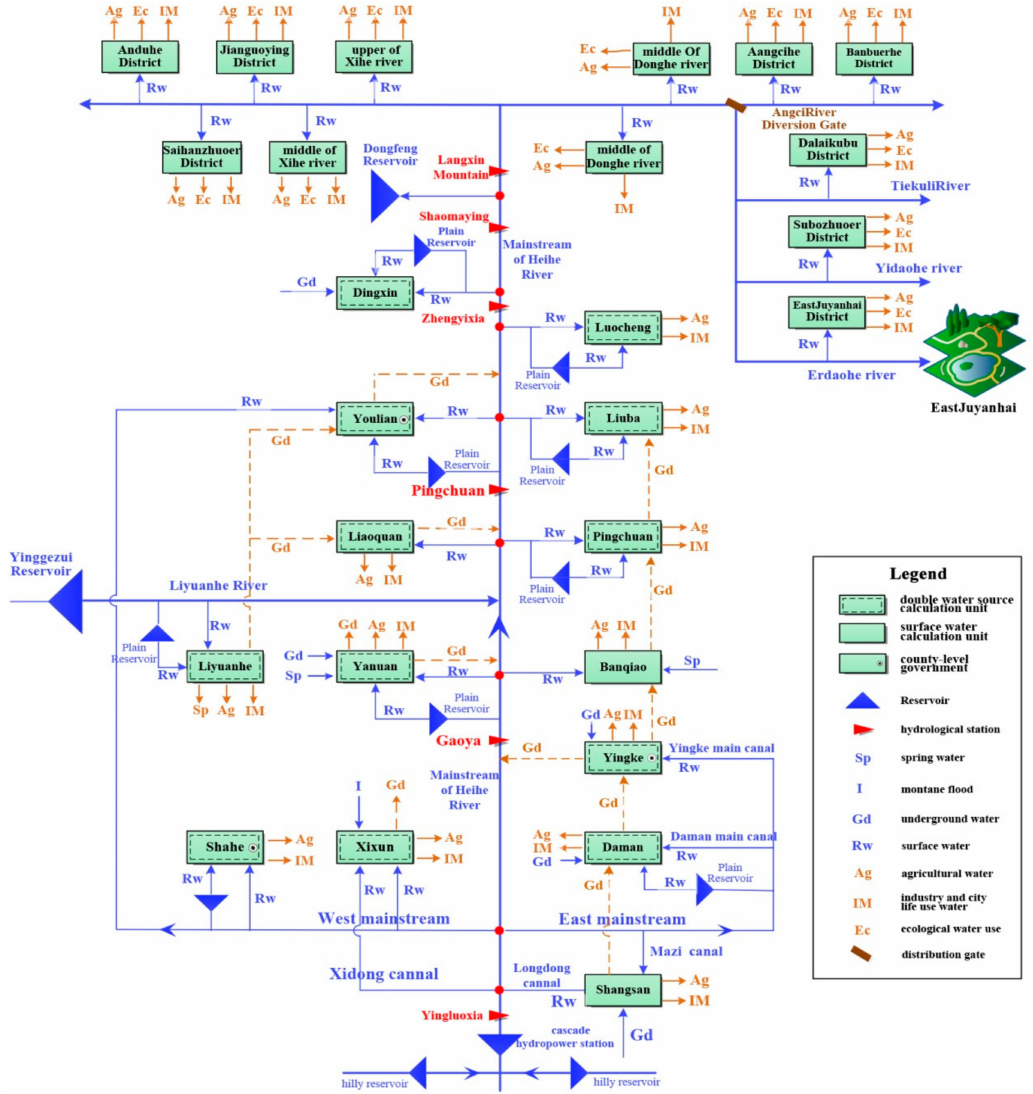
Figure 3. Framework of the water resource system in the Heihe River Basin.